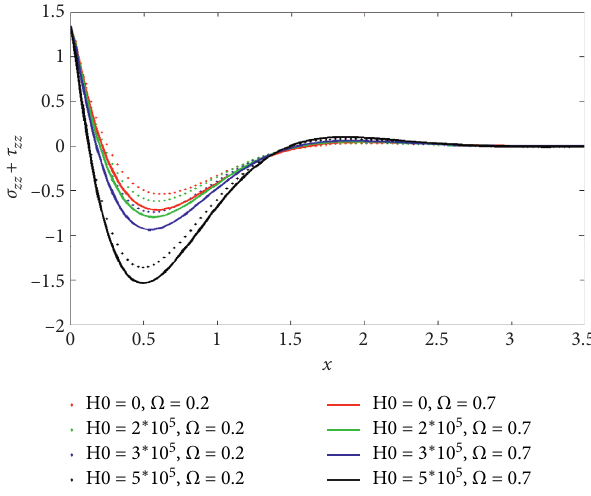
x with magnetic and rotation. zz concerning